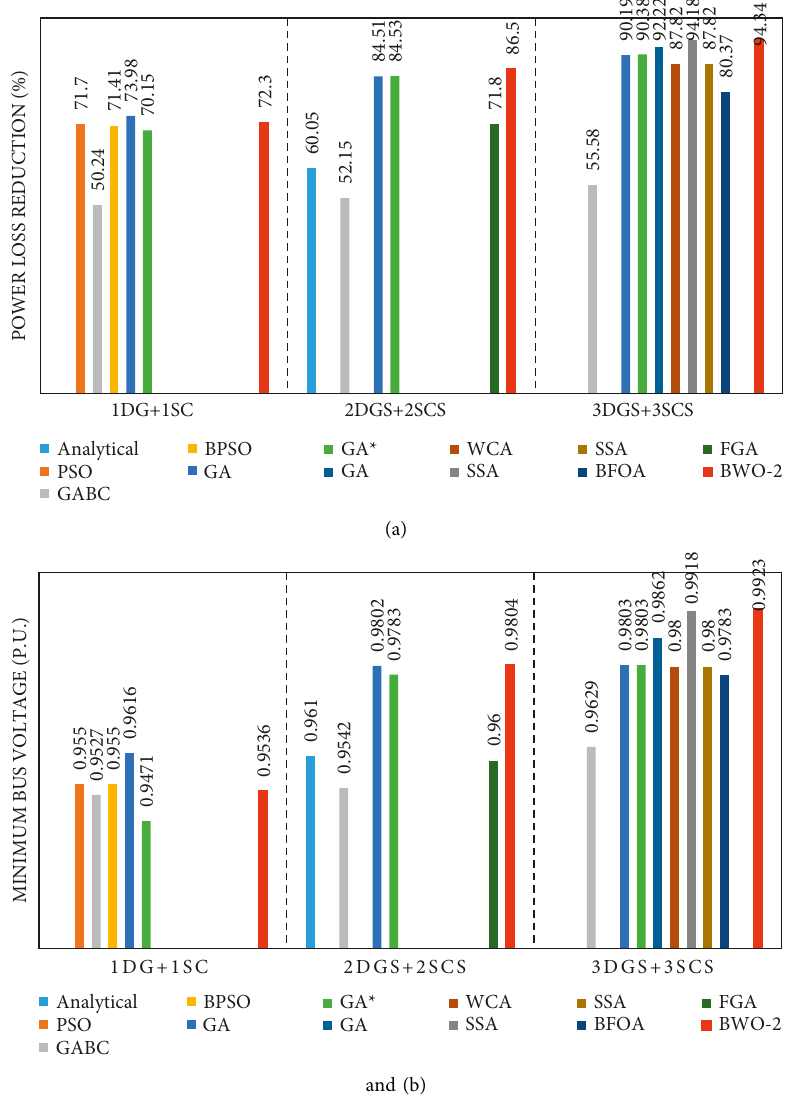
Figure 12: Performance comparison of BWO-2 against the established optimization algorithms for (a) power loss reduction and (b) minimum bus